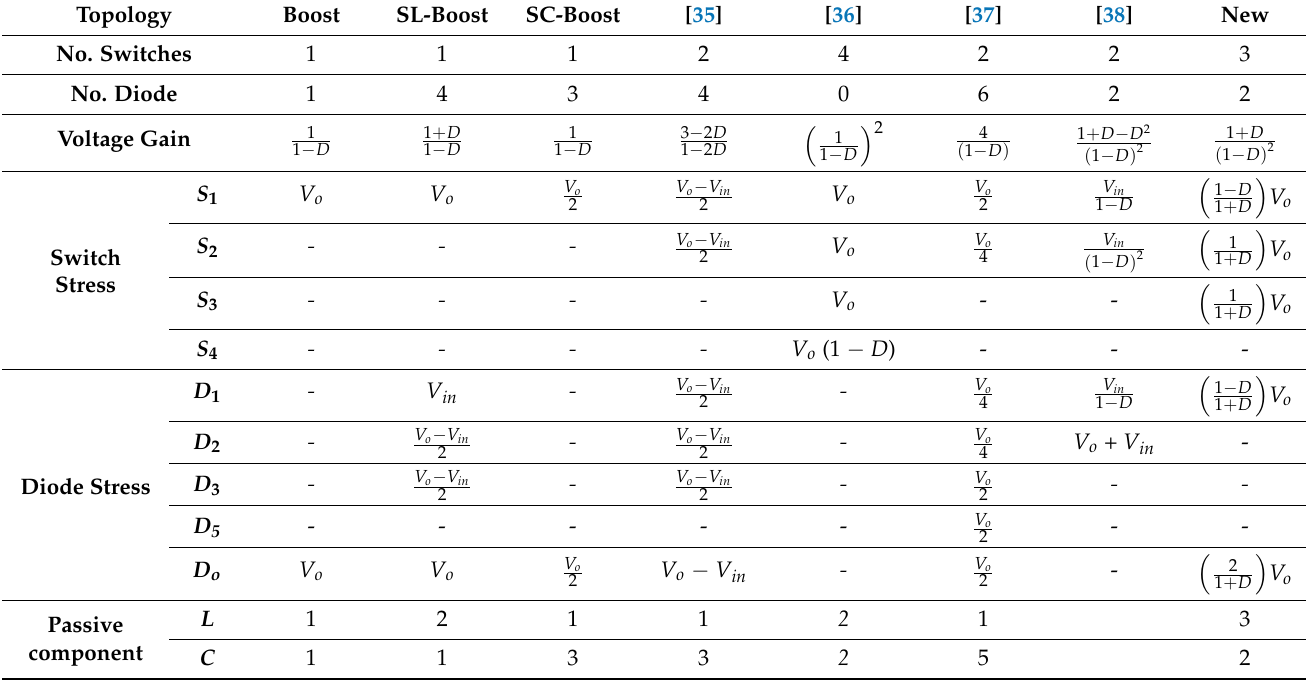
Figure 20. The voltage gain comparison among different dc-dc step-up topologies. Table 4. The comparison of Step-up Topologies.